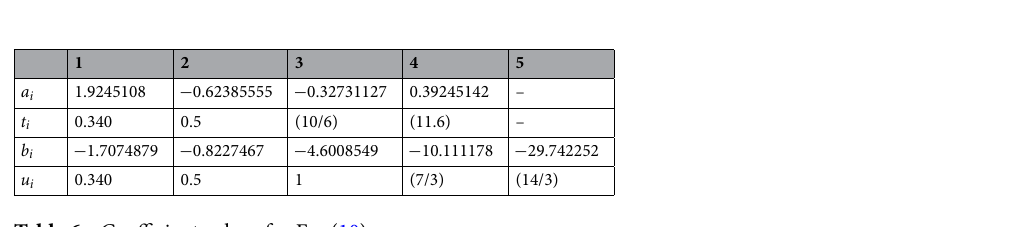
Table 6. Coefficient values for Eq.